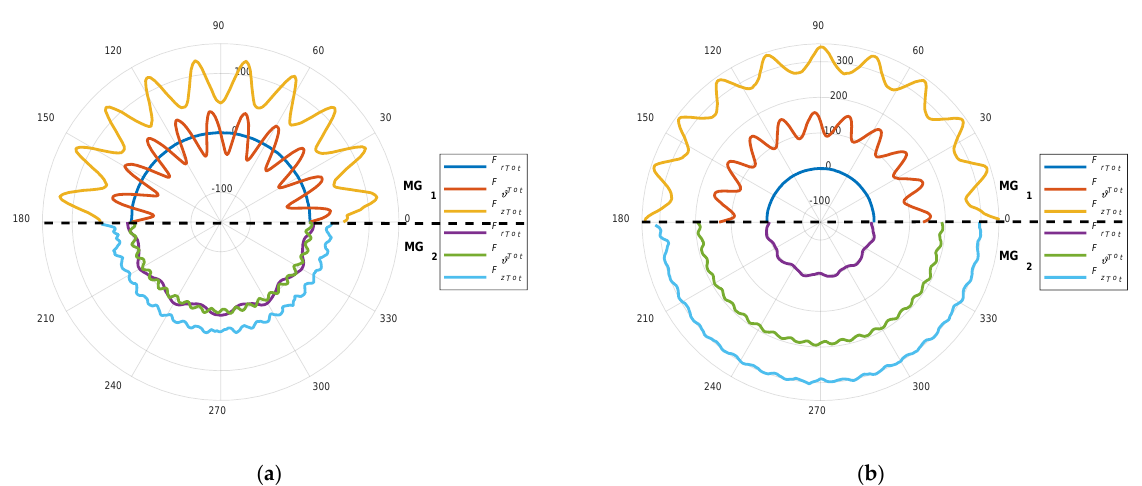
Figure 9. Global force components acting on the whole modulator vs. inner rotor angle, for two gear variants (upper chart part MG 1 , lower chart part MG 2 ) at ( a ) no load and ( b ) max. load.